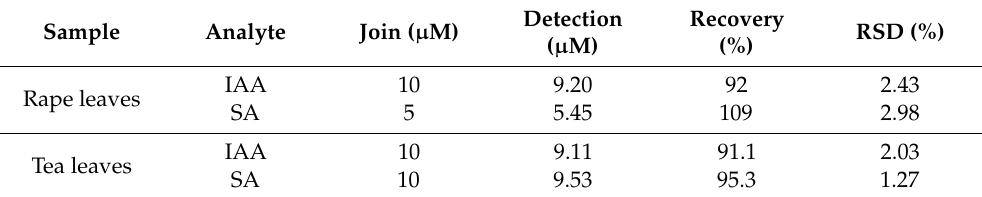
Table 3. Determination of IAA and SA levels at the CuNPs-CSF-CNPs-MWCNTs/GCE in 0.1 M PBS (pH 7.0) containing real